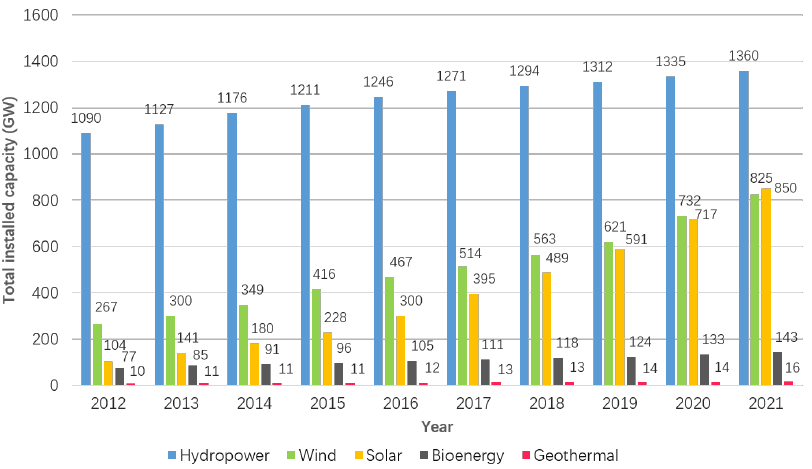
Figure 1. Global renewable energy installation